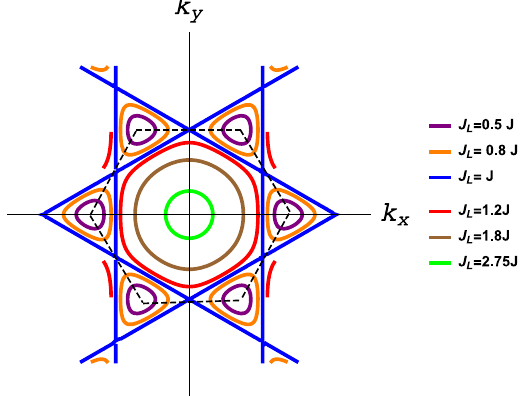
Figure 4. Dirac magnon closed loops in momentum space for several values of J L / J . The dashed black hexagon represents the Brillouin